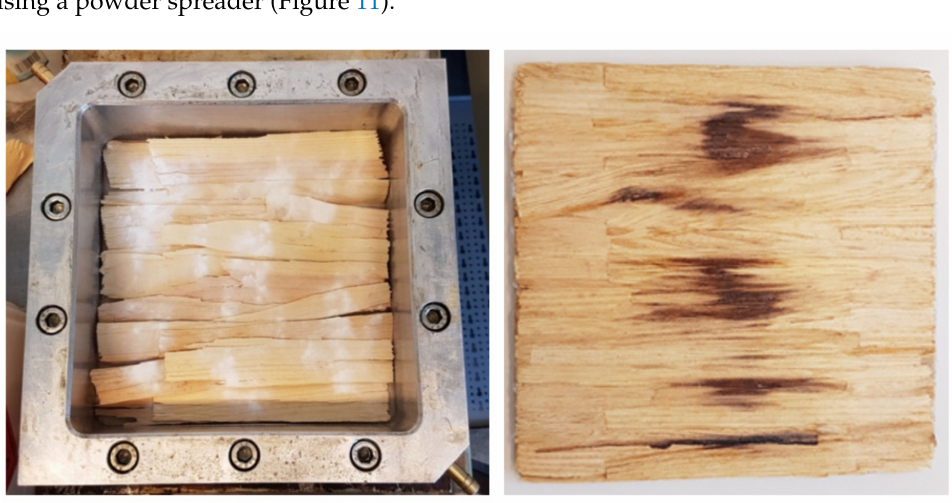
Figure 11. Manual production of WPC specimens consisting of OSB strands and thermoplastic